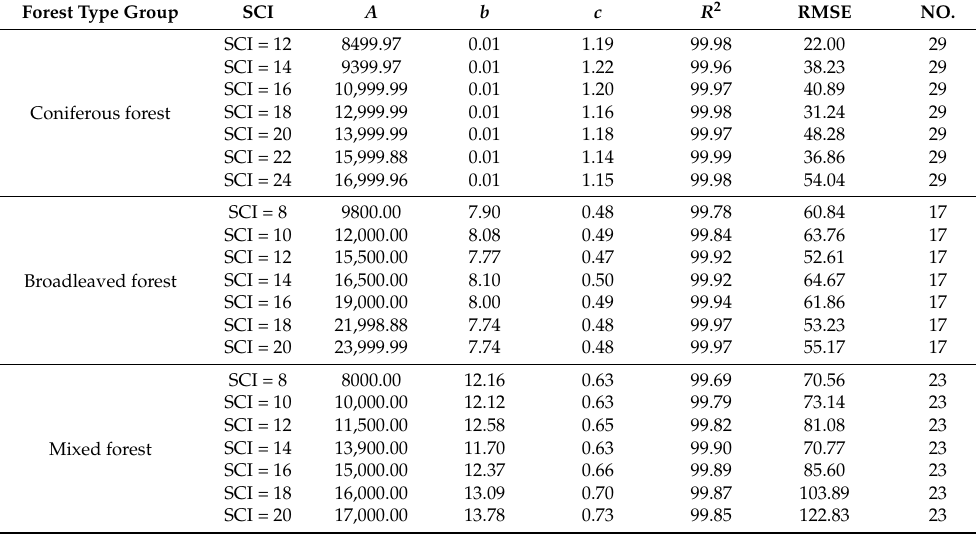
Table A2. The Regression Coefficients for Equations (6) and (7) in three main forest type groups. Forest Type